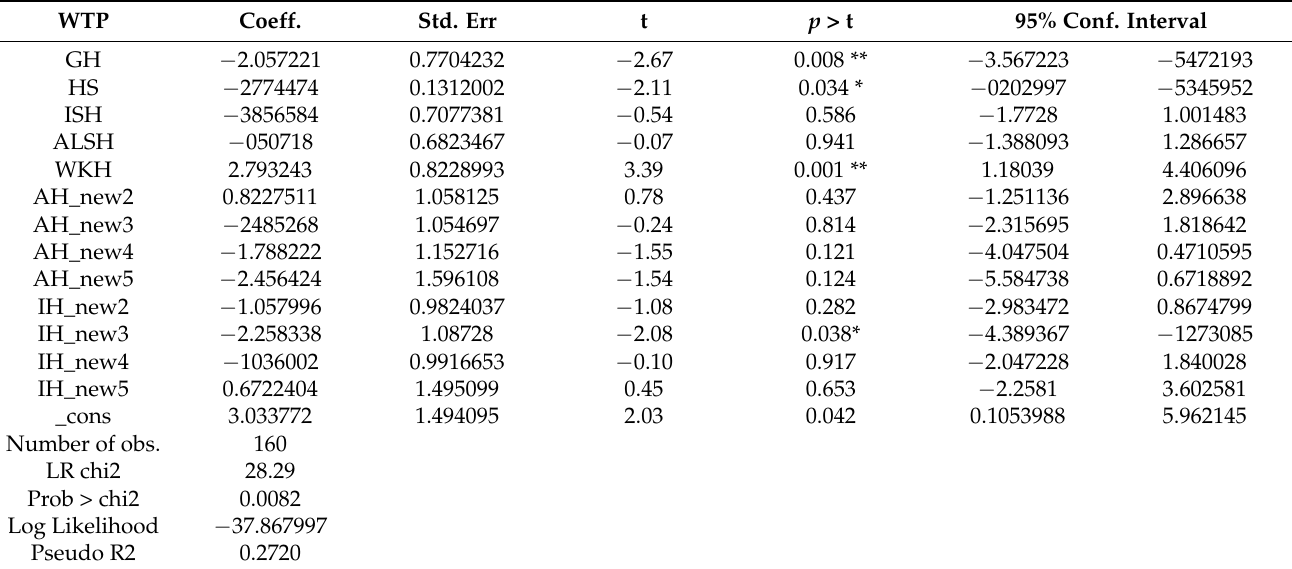
Table 4. Results of ordered logistic regression on determinants of the WTP model A.